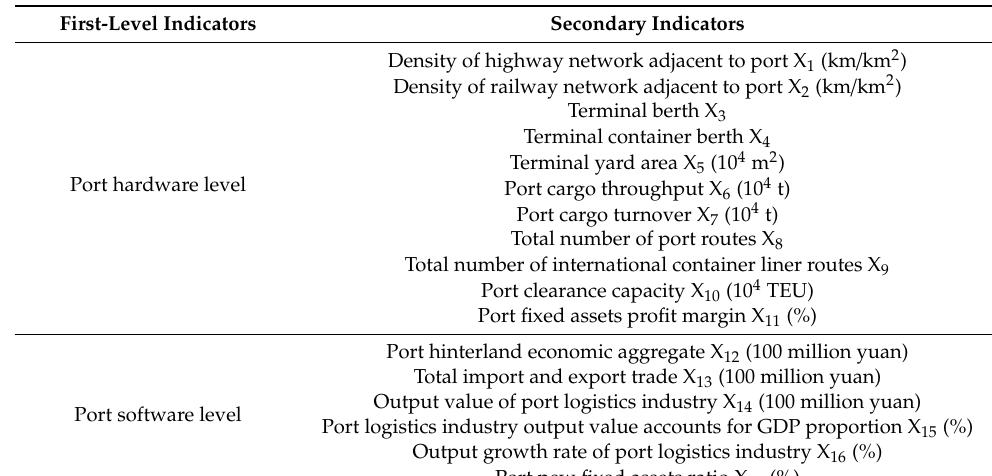
Table 1. Evaluation index system of port logistics